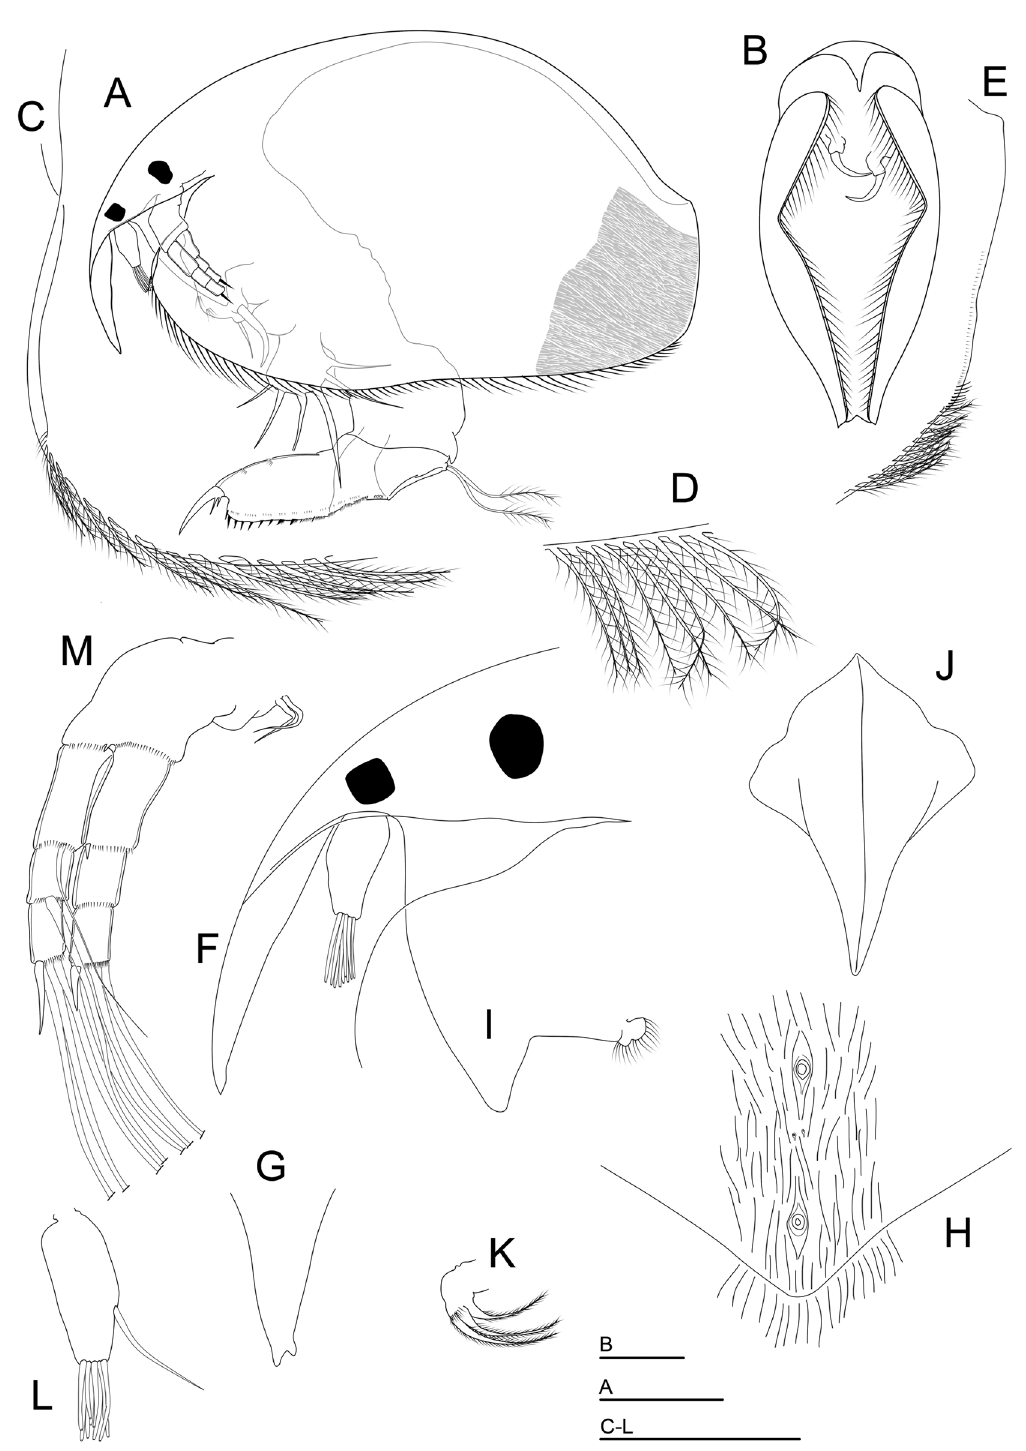
Fig. 4. Disparalona ( Mixopleuroxus ) hamata (Birge, 1879), parthenogenetic female. A . Habitus. B . Ventral view of carapace. C . Anterior portion of ventral margin of carapace. D . Middle portion of ventral margin of carapace. E . Posterior portion and posteroventral corner of carapace. F . Rostrum. G . Idem , frontal view. H . Main head pores. I . Labrum. J . Idem , frontal view. K . Maxilla. L . Antennule. M . Antenna. Scale bars: C–L = 50 μm; A–B = 100